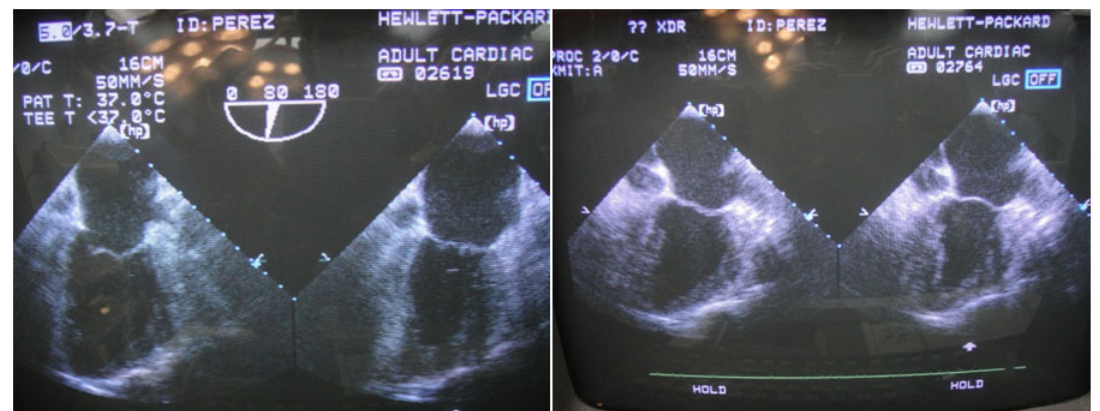
Fig. 5 - Transesophageal echo performed before (left) and after (right) the anastomosis in the same patient conditions: anesthetic drugs, use of inotropics and balloon